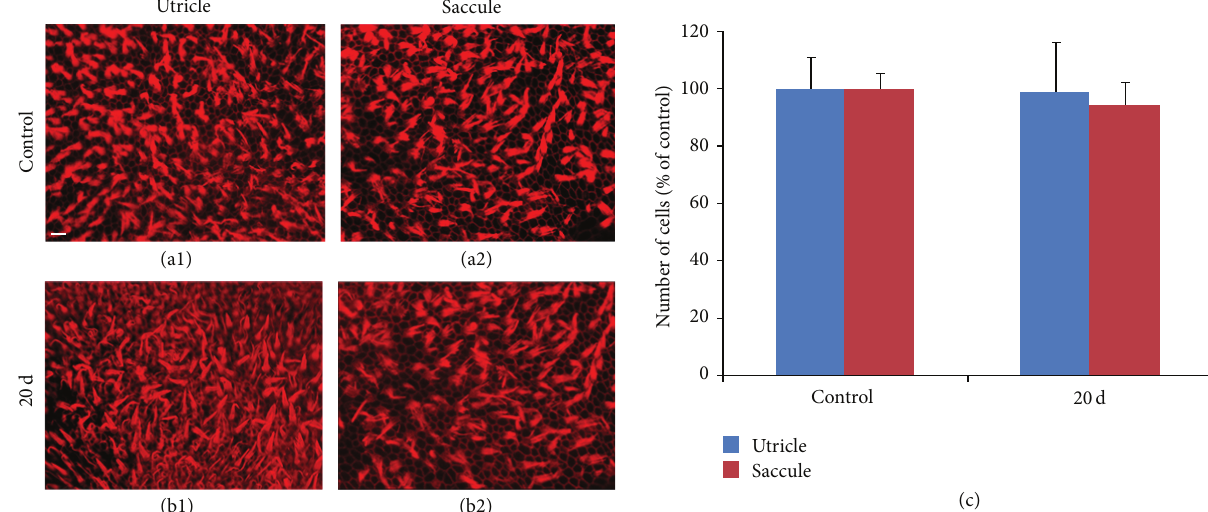
Figure 5: Whole mounts and hair cell counts of utricles and saccules in normal (a1 and a2) and cochleostomy (b1 and b2) ears at 20 days, stained with phalloidin (red). No significant differences in hair cell counts were observed between the cochleostomy and normal ears (c). (a1) and (b1): utricle; (a2) and (b2): saccule. Scale bar = 50 𝜇 m.